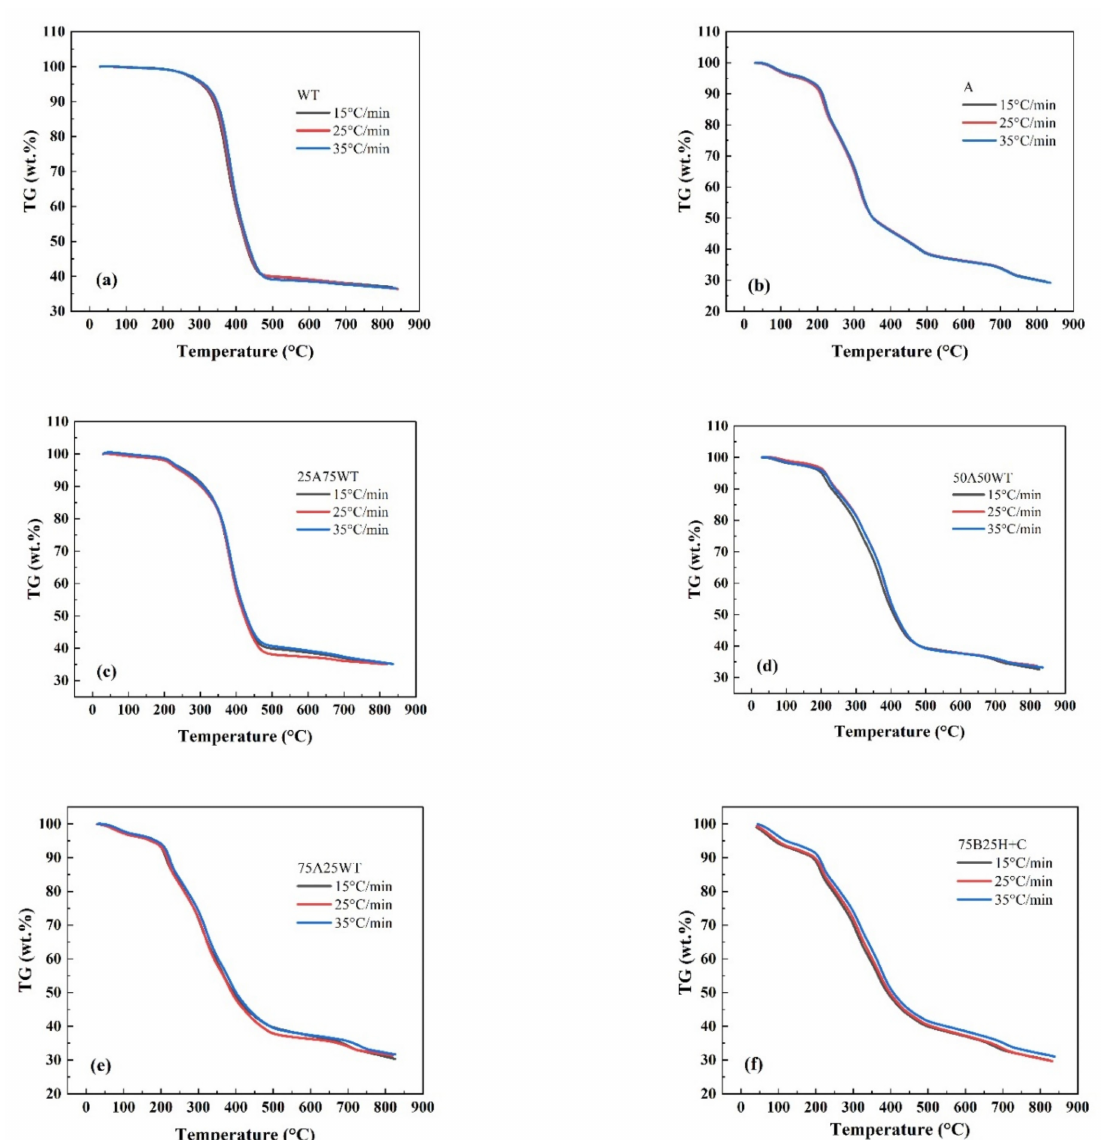
Figure 1. TG curves of ( a ) WTS, ( b ) AP, and ( c – f ) their blends at three different heating